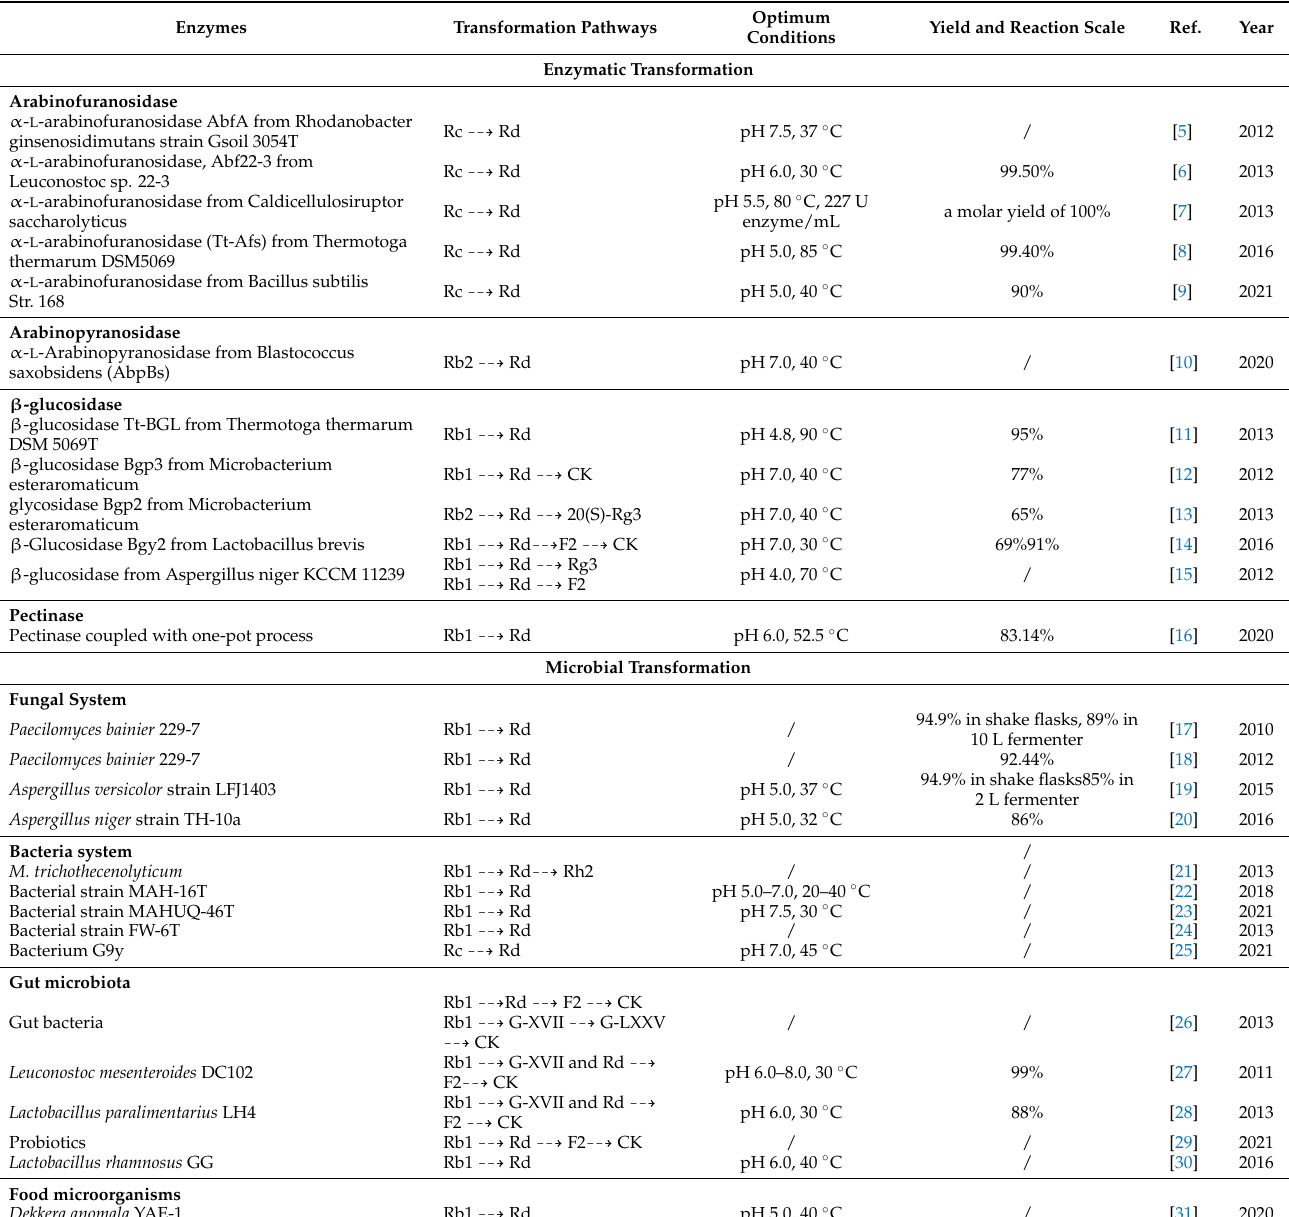
Table 1. Bioconversion of major ginsenosides into